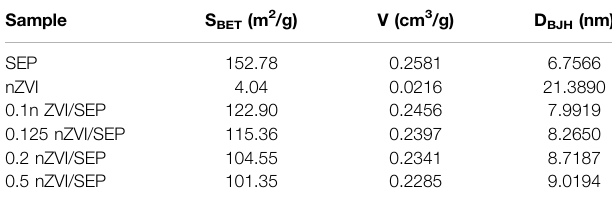
TABLE 1| Pore structural characteristics ofSEP,nZVI andnZVI/SEPcomposites.